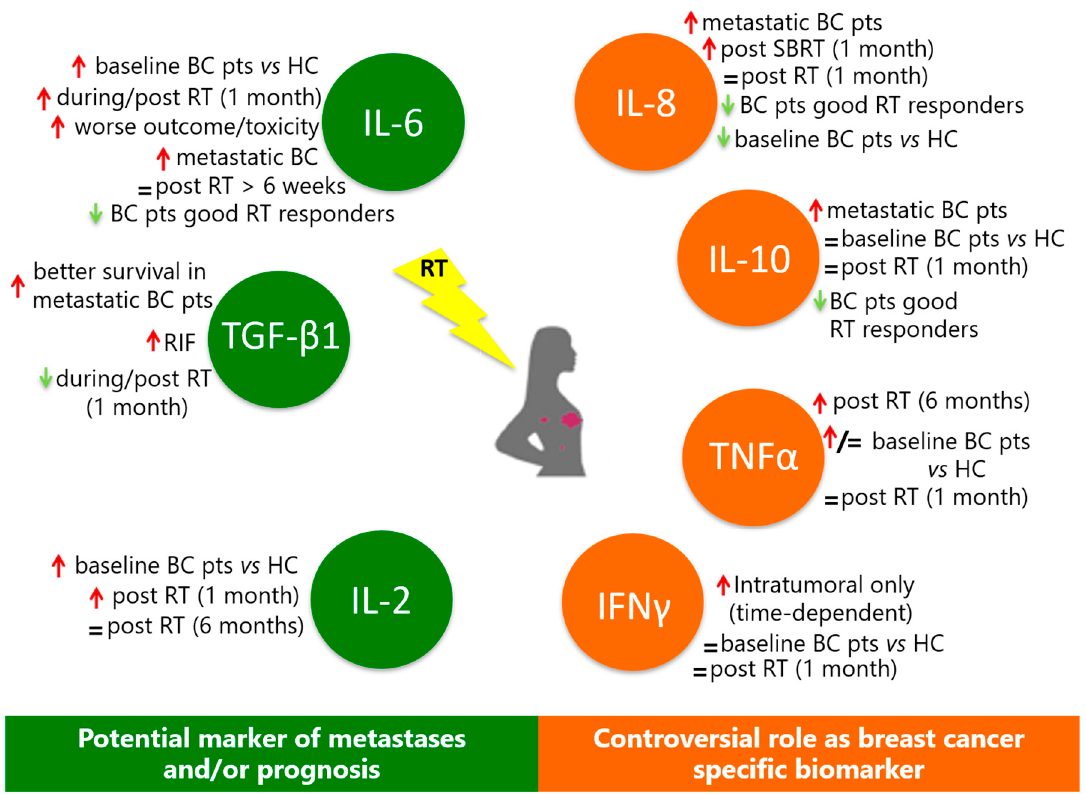
Figure 1. Summary of main examples of evidence regarding cytokine modulation in BC patients undergoing radiotherapy from an analysis of clinical studies published in the last five years. Red and green arrows indicate increase or decrease of cytokine concentrations, respectively.